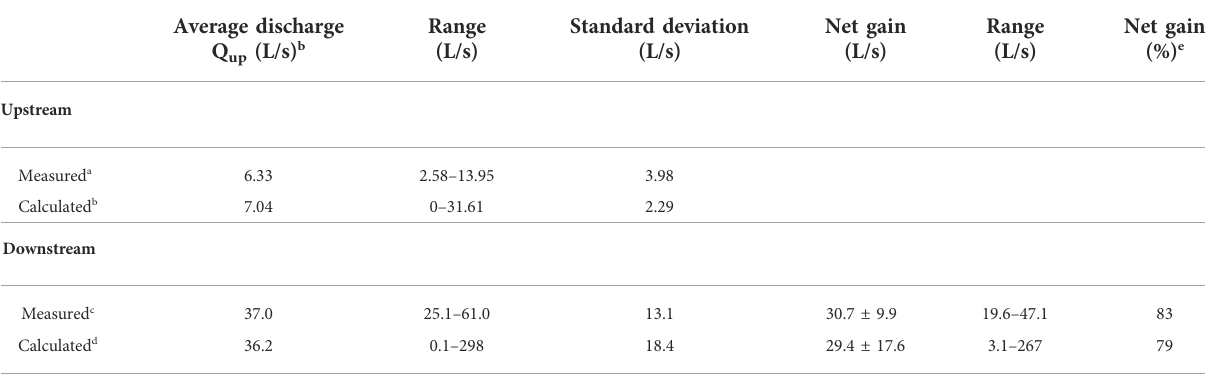
TABLE 2 Summary of pre-restoration stream fl